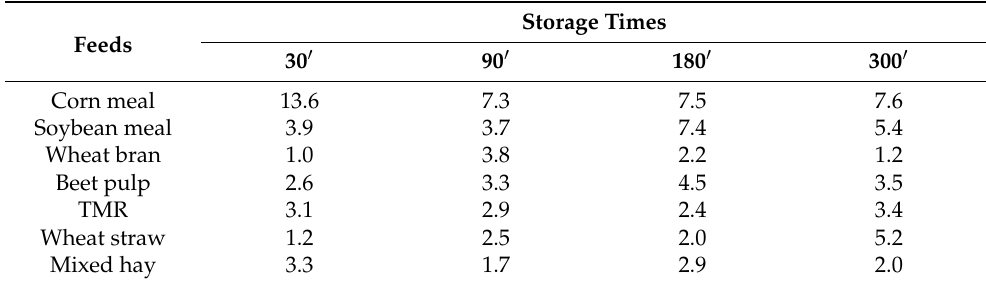
Table 3. Average standard deviation of NDFD ADII of different feeds at different storage time (MSE = 7.98, N = 130).